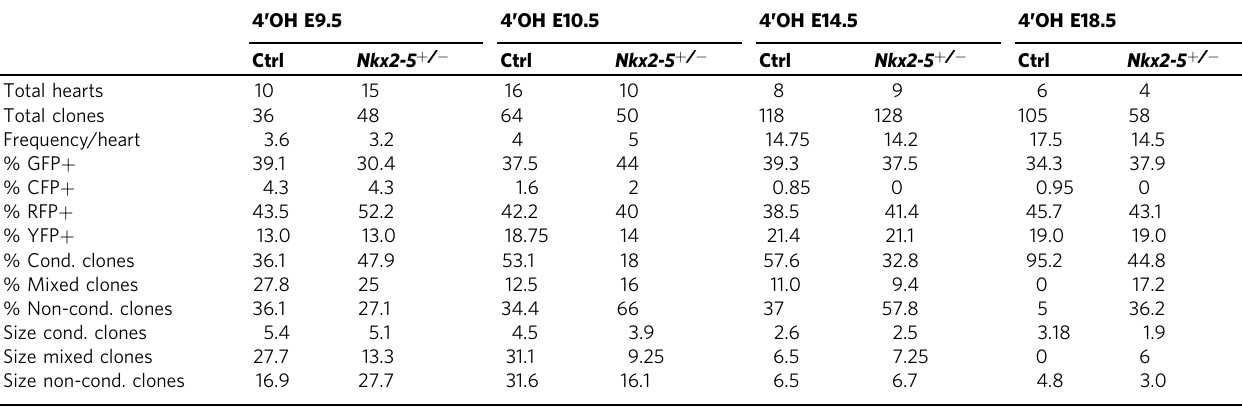
Table represents the n values of hearts and clones analyzed in this study, using Cx40-CreERT2::R26R-Confetti mouse line. Only clones observed in the subendocardial surface of the inter-ventricular septum within the left ventricle are analyzed. Percentages of colors and type of clones are represented. The size of clones are measured by quantifying the number of cells per